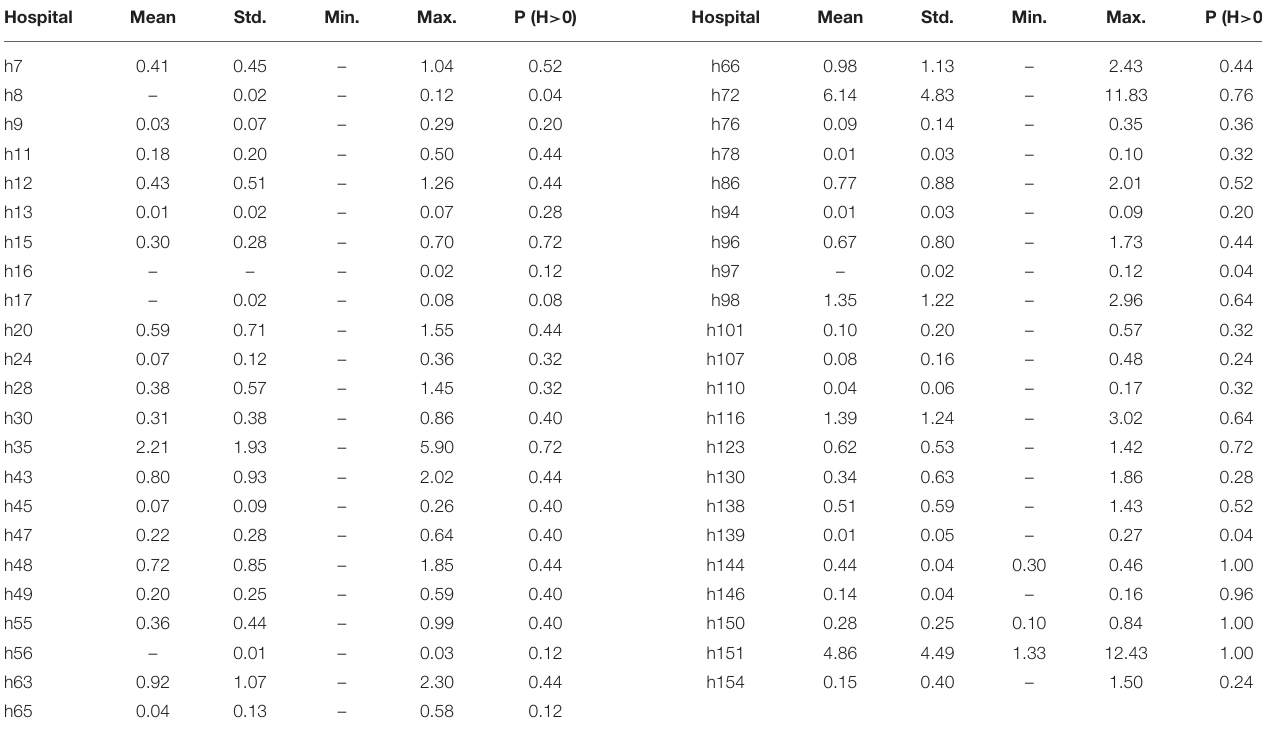
TABLE 4 | Flood statistics (in meters) and probability of flood level (H) greater than zero for hospitals in the region of interest. Hospital